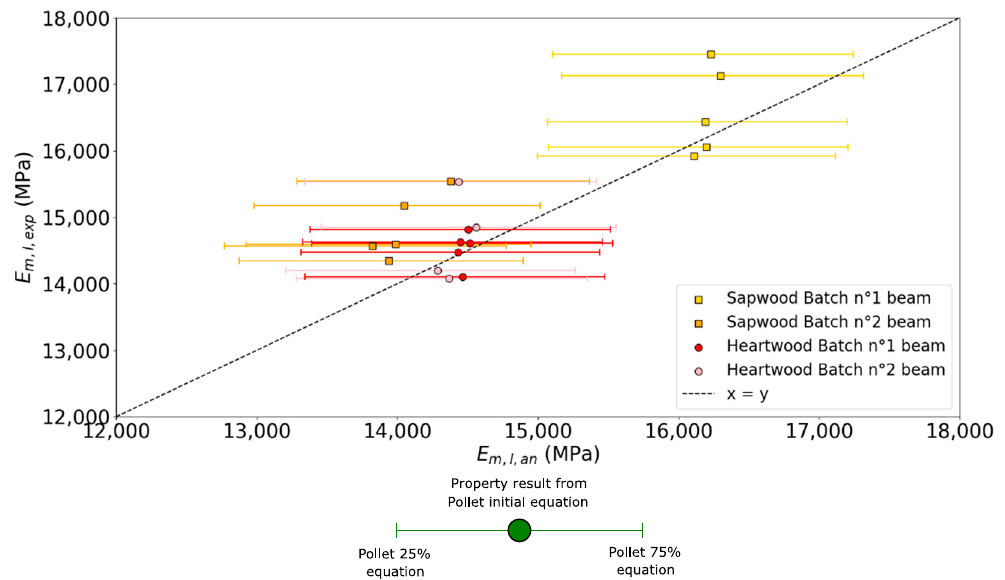
Figure 7. Scatter plot between analytical and experimental local modulus of elasticity.